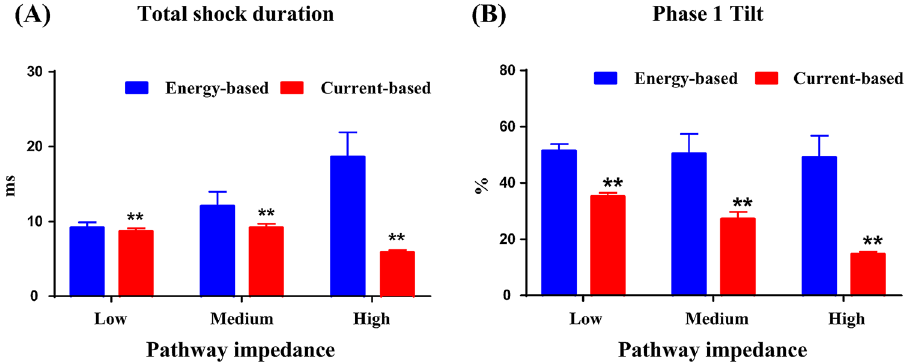
Figure 4. Total shock duration ( A ) and the phase 1 tilt ( B ) of the current-based and energy-based defibrillations at different pathway impedances.